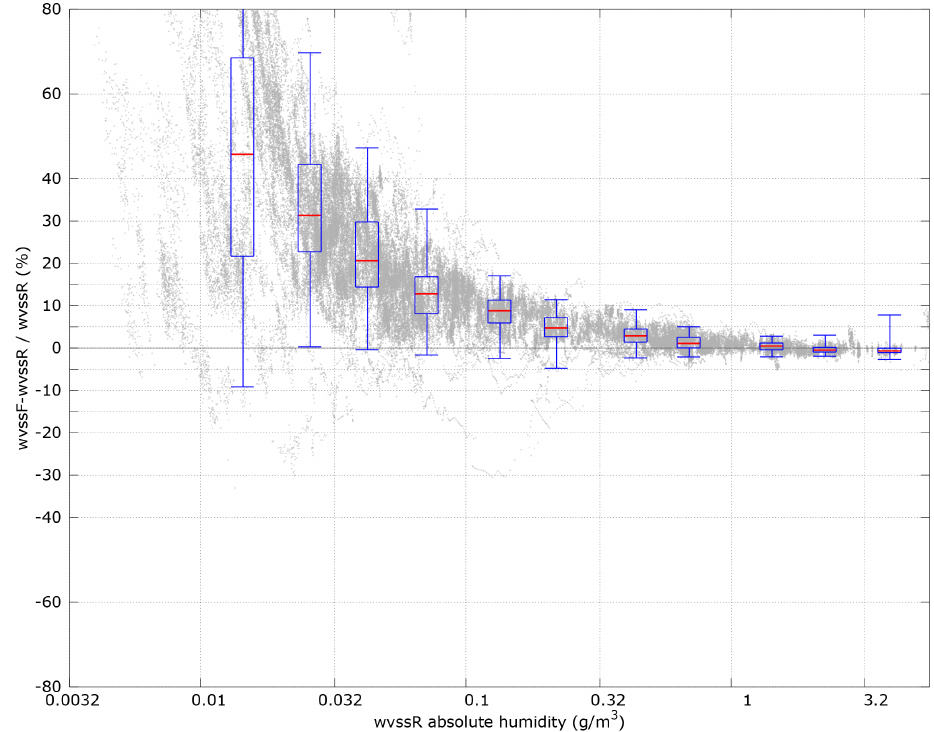
Figure 4. wvssF minus wvssR in cloud free conditions. Boxes indicate binned quartiles, with the whiskers at 2nd and 98th percentiles.